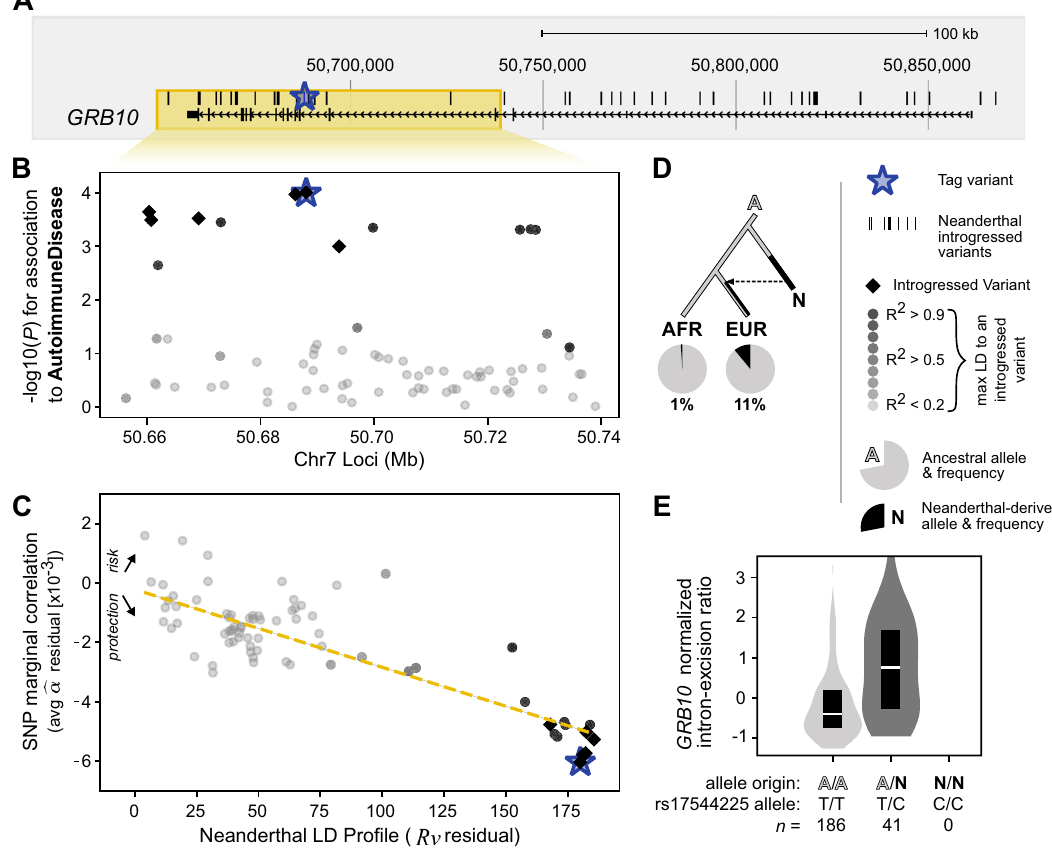
Fig. 4 Signed LD pro fi le regression identi fi es a candidate functional association between an introgressed haplotype in GRB10 and autoimmune disease. A A genomic region overlapping GRB10 (chr7: 50,649,920 − 50,739,129, yellow box) contains an introgressed haplotype. B GWAS Manhattan plot for this region showing associations with autoimmune disease from the UK Biobank ( n = 459,324). The strongest single-variant association is at an introgressed variant, but it does not reach genome-wide signi fi cance (blue star, P = 9.8 × 10 − 5 at rs17544225). C Using SLDP regression, we discover a strong negative relationship between LD to introgressed alleles and autoimmune disease in this region. The negative correlation between Neanderthal LD pro fi le and autoimmune disease risk suggests a protective relationship between Neanderthal introgression at this locus and autoimmune disease ( r = − 0.84). Thus, while the single-variant association alone is not suf fi cient to implicate this introgressed haplotype in autoimmune disease risk, considering LD to Neanderthal alleles and the direction of effect across variants identi fi es it as a candidate. D The haplotype (tagged by starred variant rs17544225) is derived in Neanderthals (N) and at 11% frequency in modern Europeans (EUR, n = 503) with 1% frequency in Africans (AFR, n = 661, only observed in admixed African Americans and Caribbeans) (1000 G super-populations). E The introgressed allele is also is an sQTL in which Neanderthal alleles associate with increased GRB10 intron excision in the spleen (two-tailed t -test P = 3 × 10 − 9 ). The boxplot centers represent medians and the boxes are bounded by the fi rst and third